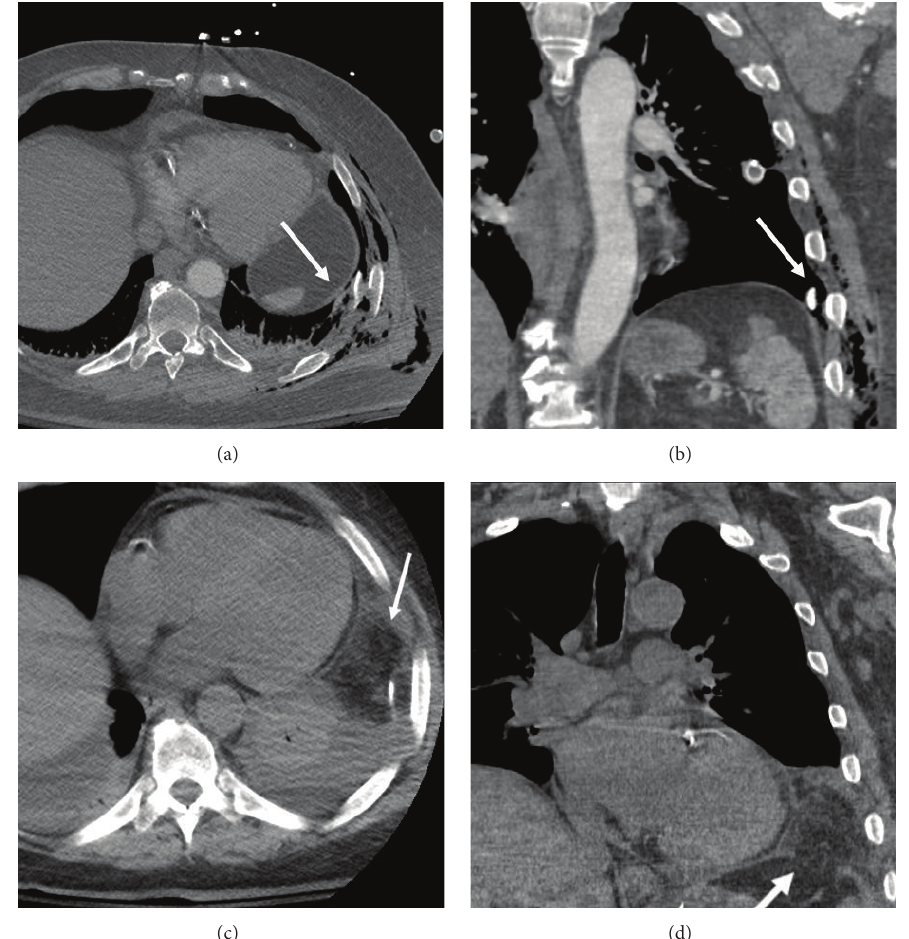
Figure 1: Fractured rib sign in a 59-year-old man after blunt trauma. (a, b) Contrast-enhanced chest MDCT (axial and coronal planes) shows left 10th-rib fracture abutting the diaphragm (fractured rib sign). The diaphragm appears intact on initial trauma CT. (c, d) Repeat chest MDCT (axial and coronal planes) 5 days later reveals new herniation of omental fat (arrows) into the left hemithorax due to subacute diaphragm rupture. Note discontinuity of the diaphragm